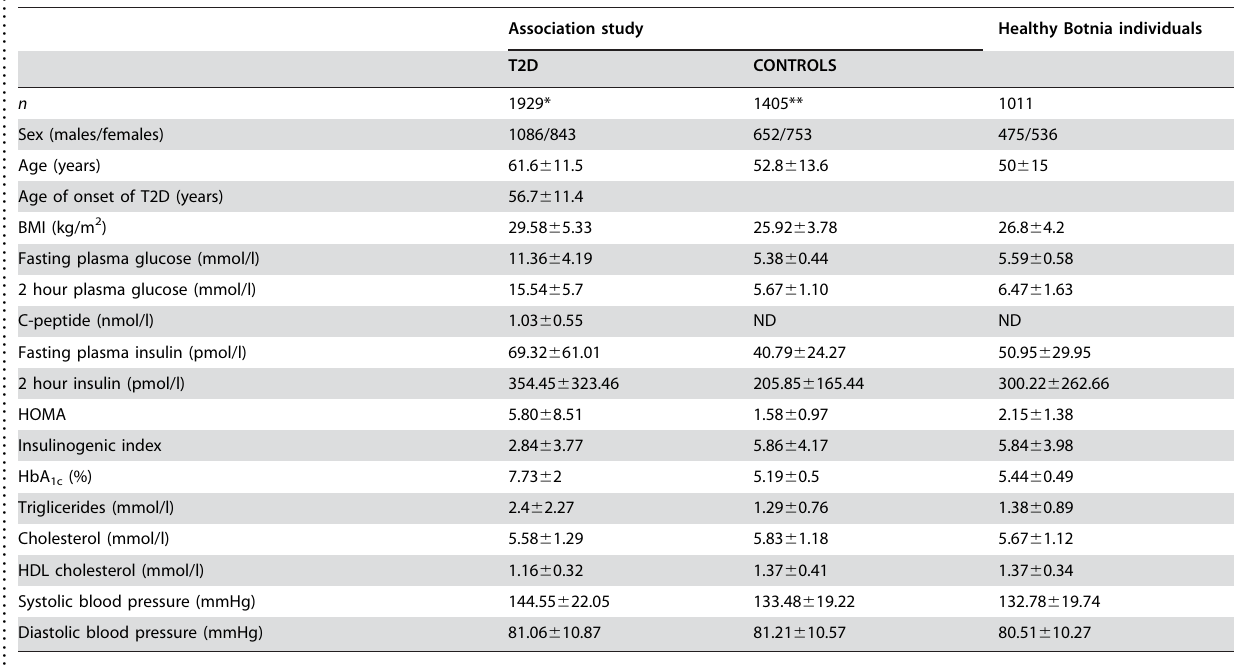
Legend to Table 1. Data are mean 6 SD. ND: not determined. * 1455 T2D patients were measured for C peptide but the rest 451–for fasting plasma insulin (HOMA index was calculated from these). Values of 2 hrs glucose and insulin were obtained for 256 and 251 individual, respectively. Insulinogenic index could be calculated for 192 T2D patients. Blood pressure information was obtained from 1438 patients. ** Values of 2 hrs glucose and insulin, HOMA, insulinogenic index and HDL cholesterol were available only in 68% of the control group but trigliceride values in 87% of the